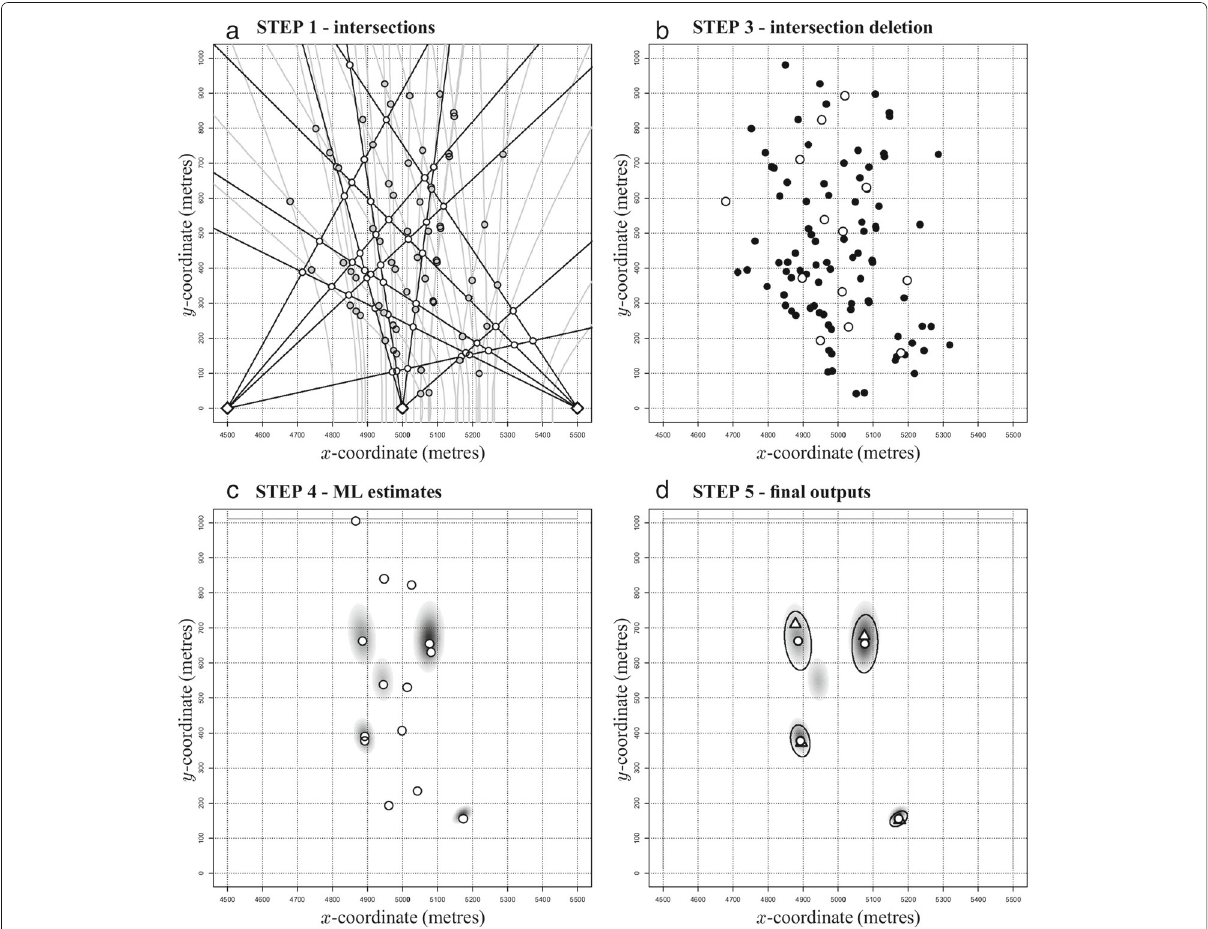
Fig. 2 Demonstration of the TALA for the scenario with four targets. a Step 1: intersection of each pair of AOA measurements ( whitecircles ) and each pair of DDOA measurement hyperbolae ( greycircles ). b Step 3: intersections that are retained ( whitecircles ), and intersections that are deleted ( black circles ; deletion criterion 3 is not used). c Step 4: ML estimates. d Step 5: downselected ML estimates ( circles ), and the true target locations ( triangles ). Each ellipse shows the 5 standard deviation error covariance associated with each ML estimate